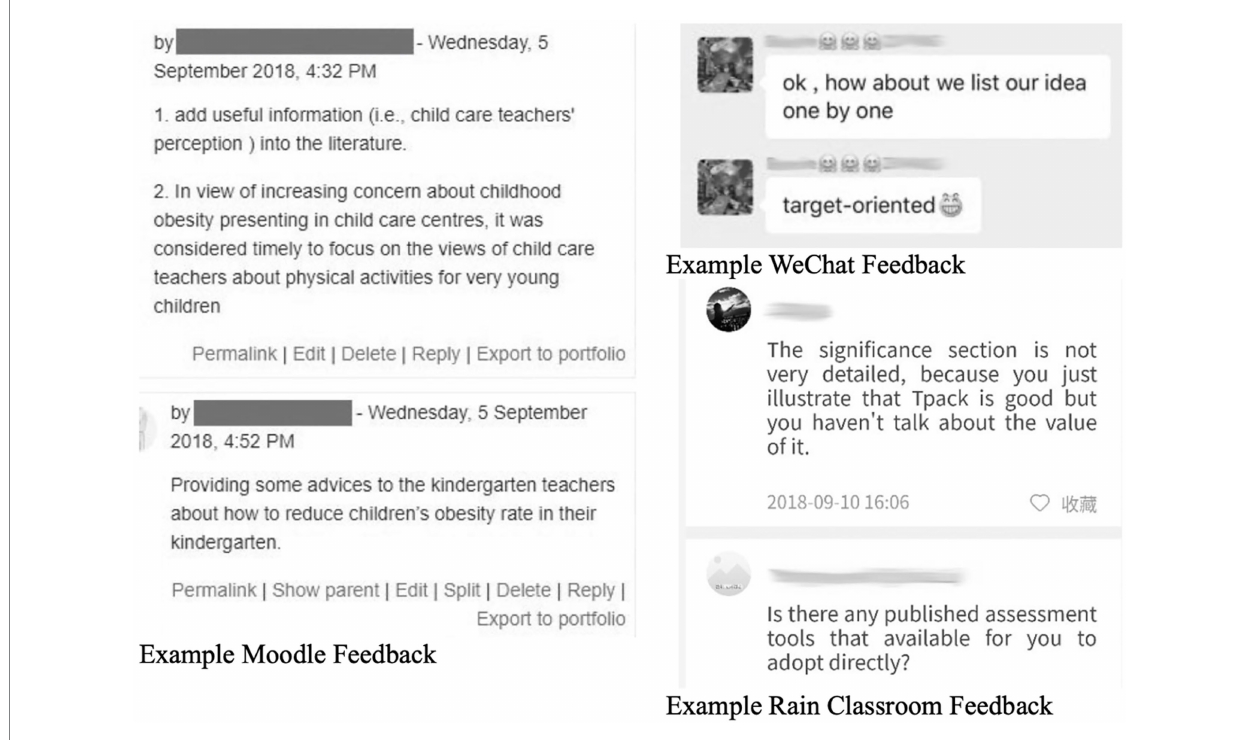
FIGURE 2 Examples of e-feedback.